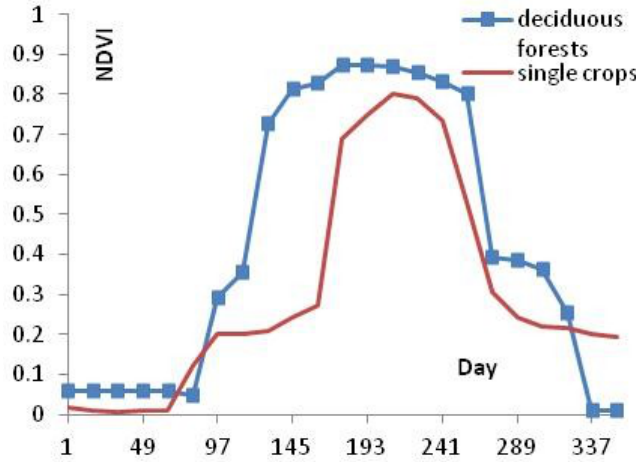
Figure 3. Time series NDVI mode curves of single crops and deciduous